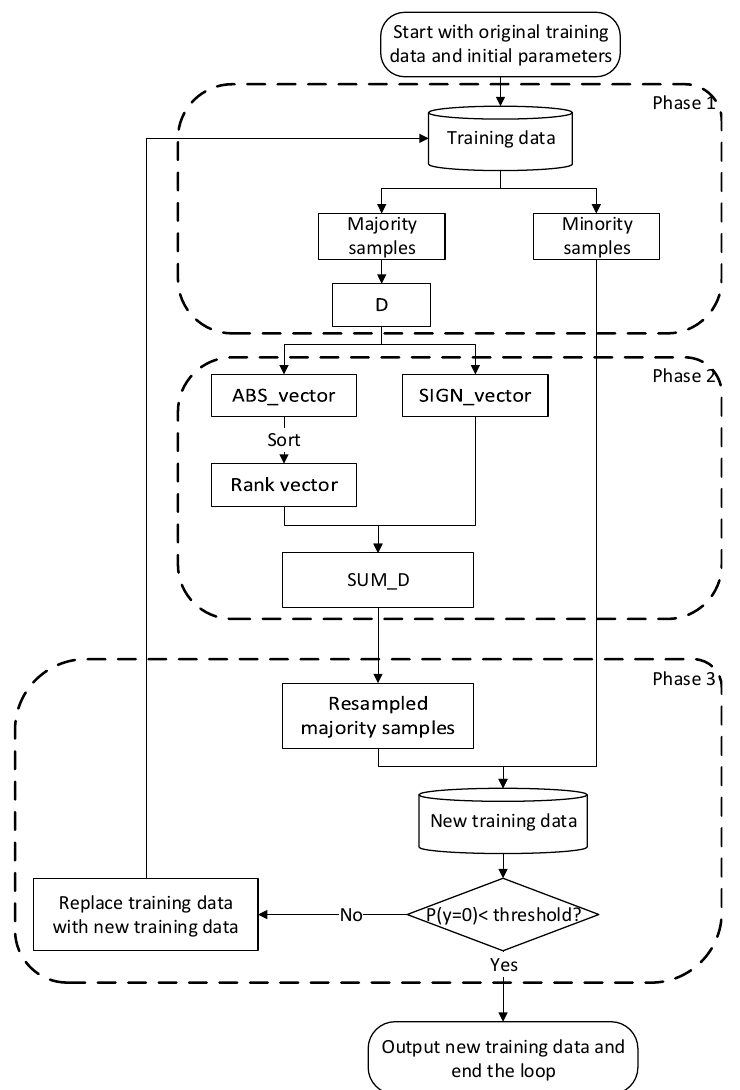
Figure 1. Overall structure of the proposed method